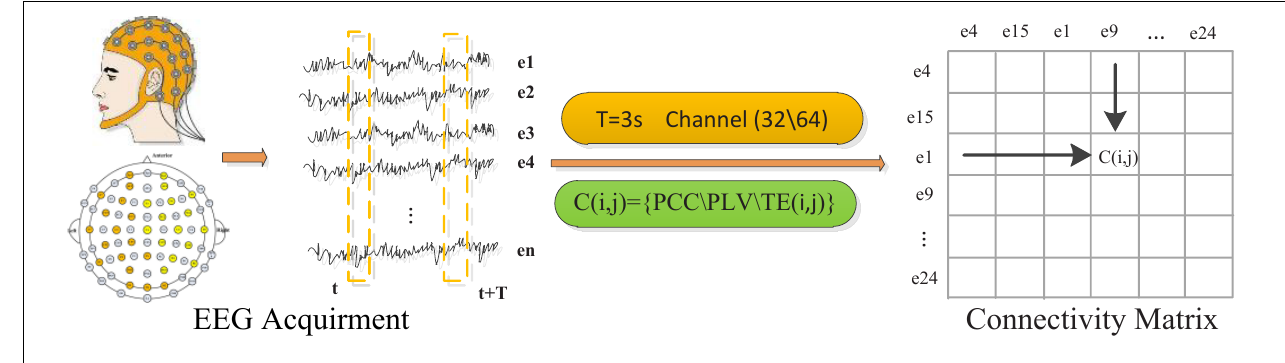
FIGURE 1 | EEG signal acquisition and connectivity feature representation.